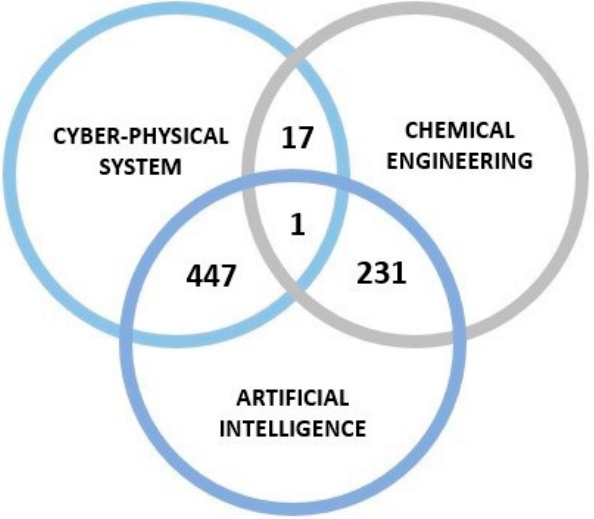
Figure 4. Venn diagram displaying the relationships between the searched keywords “cyber- physical system”, “chemical engineering” and “artificial intelligence”.